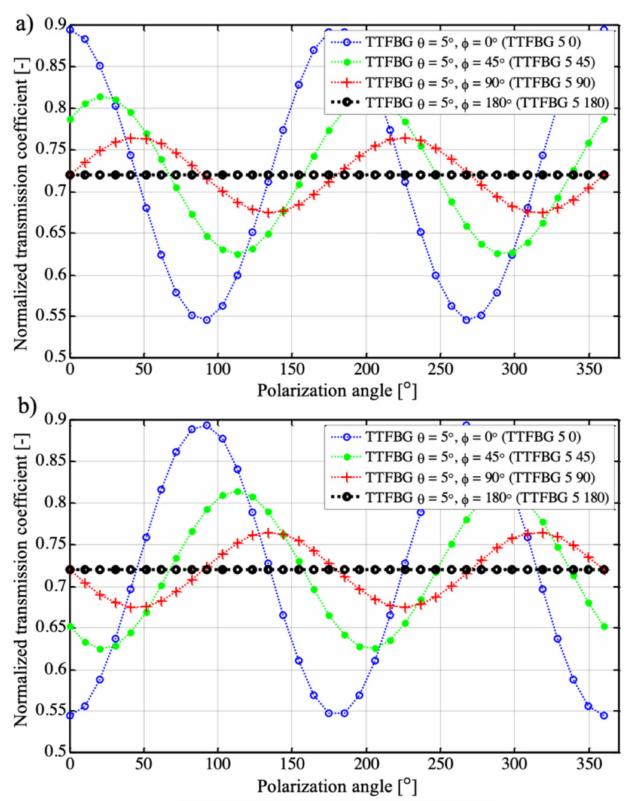
Figure 11. Results of numerical calculations of changes in the transmission coefficient of the TTFBG structure for various φ angles: ( a ) for P-type mode, ( b ) for S-type mode.